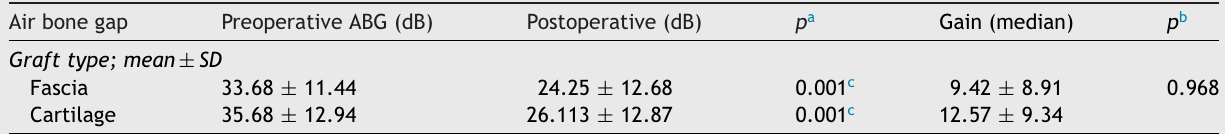
a Paired samples test. Comparison ABG between two groups pre- and postoperatively. b Mann---Whitney U test. Comparison between two groups in terms of gain. c p <